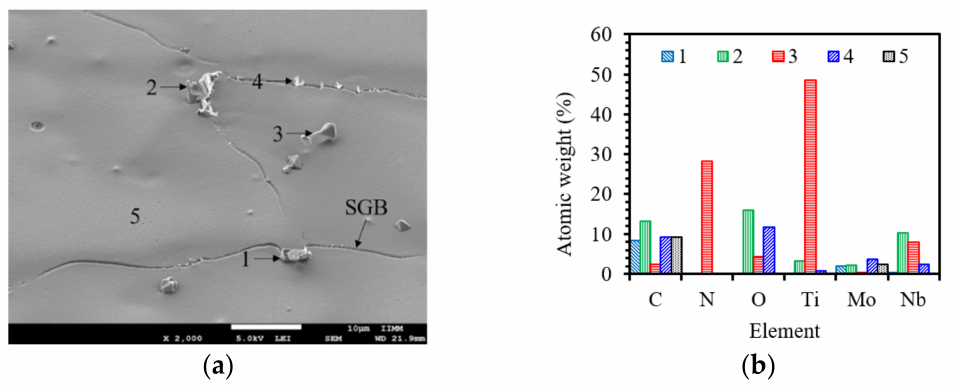
Figure 5. ( a ) The SEM image at the weld metal with the ERNiCrMo-3 filler and ( b ) the results of the EDX dot chemical compositions of the points indicated in ( a